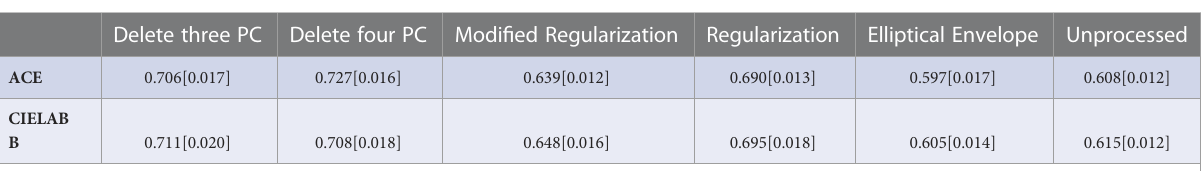
TABLE 2 Youden Index and [Standard Error].